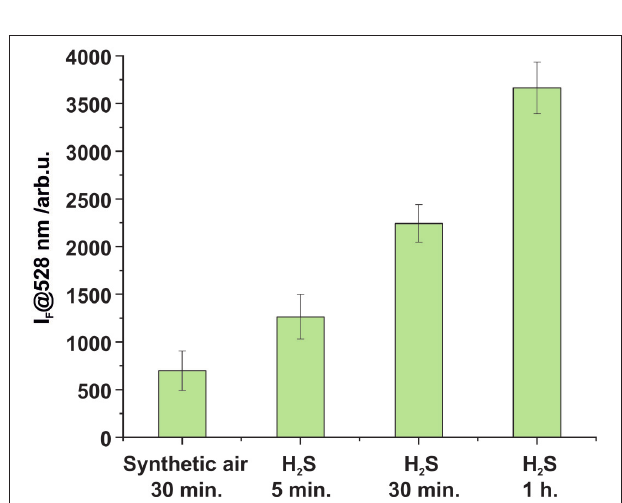
FIGURE 7 | Fluorescence enhancement observed after the exposure of complex 1 loaded on top of a hydrogel matrix (5 × 10 − 8 mmol per well)